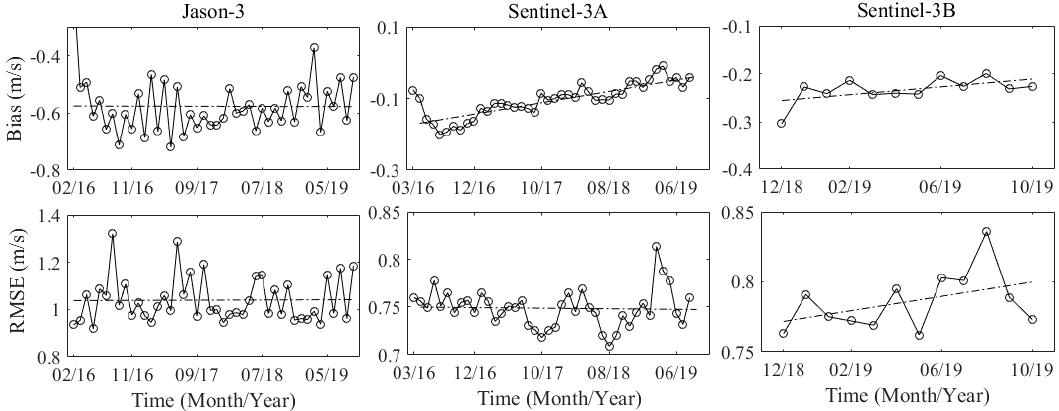
Figure 9. Monthly RMSEs and biases of WS differences between the Sentinel-3A/3B and Jason-3 altimeters and ASCAT across the different months. the dotted straight lines represent the fitting trends.